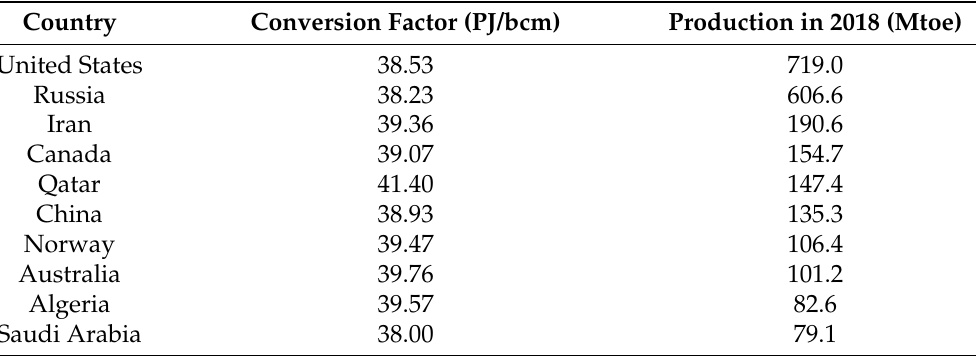
Table 3. Indicative Gross Heating Value of natural gas of the ten major producing countries. Source: IEA (2021) [78]. Country Conversion Factor